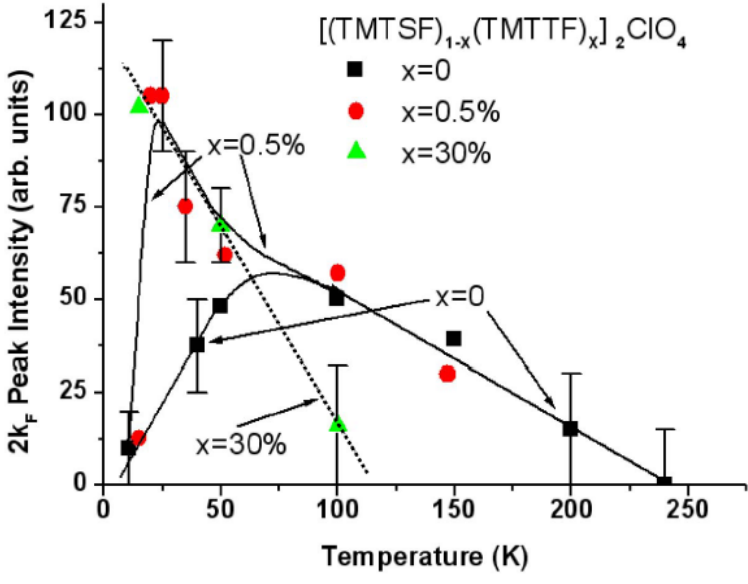
Figure 4. Thermal dependence of the 2k peak intensity, I(2 k F [(TMTSF) (TMTTF) ] ClO for x = 0 (black squares), 0.5% (red circles) and 30% (green 1− x x 2 4 triangles) of TMTTF deduced from the data reported in [40] and